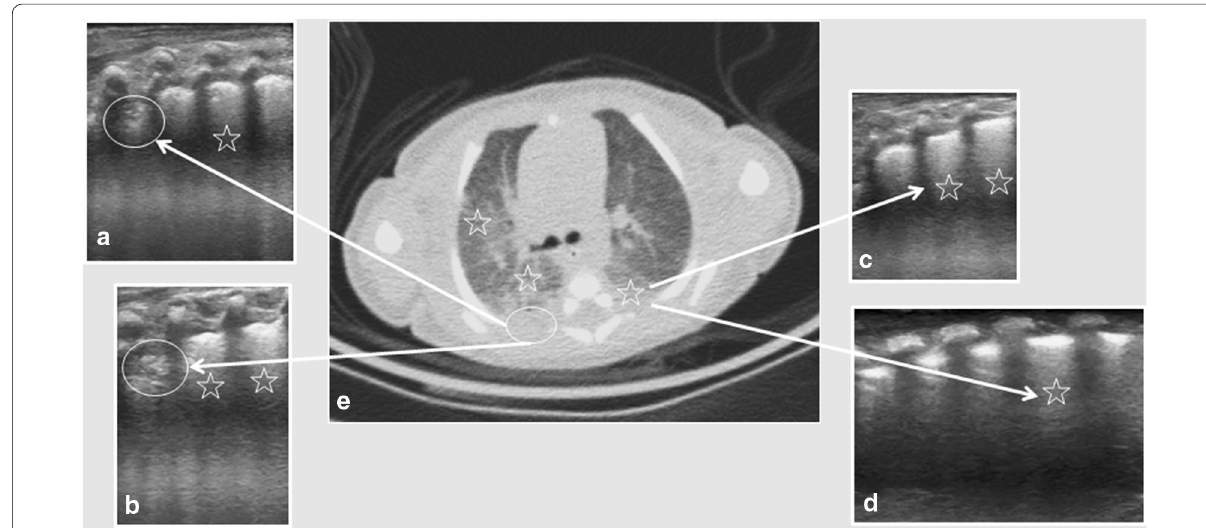
Fig. 3 Thirteen‑day‑old male preterm newborn, presented with hypoxemia, tachypnea and high D‑dimer level. Lung US ( a – d ) showed irregularities of the pleural line and small subpleural consolidations in the posterior right lung field (circles in a , b ). Confluent B‑lines (stars in a – d ) were also present in the bilateral posterior and inferior lung fields corresponding to the chest CT ( e ) ground‑glass pattern (stars in e ). Chest CT showed good correlation with lung ultrasound findings (arrows in a – e